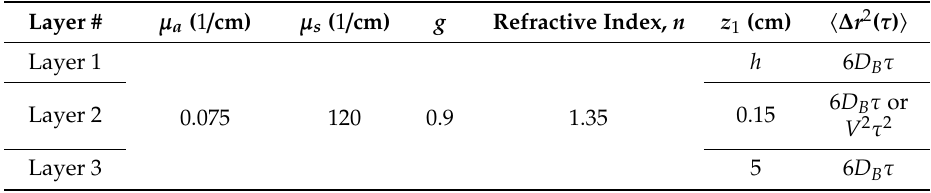
Table 1. Optical coe ffi cients used for simulations of three-layered tissue